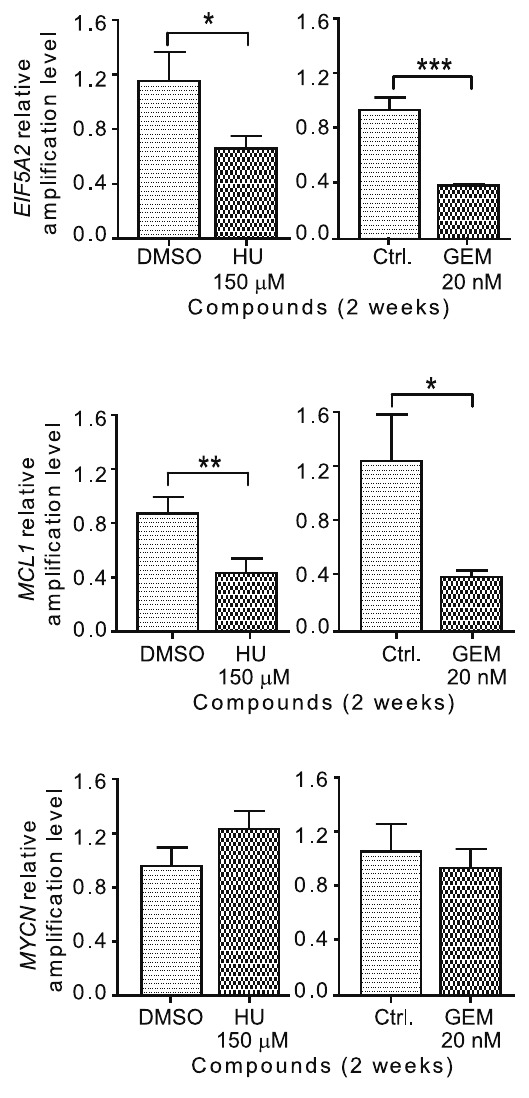
Figure 3. The amplification of genes present on DMs is decreased in UACC-1598 cells grown in the presence of HU and GEM by real-time PCR analysis. The amplification level of genes EIF5A2 , MCL1 , and MYCN was analyzed by real-time PCR. The amplification level of each gene in compound treated cells is compared to control cells (DMSO for HU treated, and Ctrl. for GEM treated), and the mean relative amplification level 6 SD is graphed. *denotes a P value of 0.01 to 0.05 and **denotes a P value of 0.001 to 0.01, ***denotes P , 0.001.